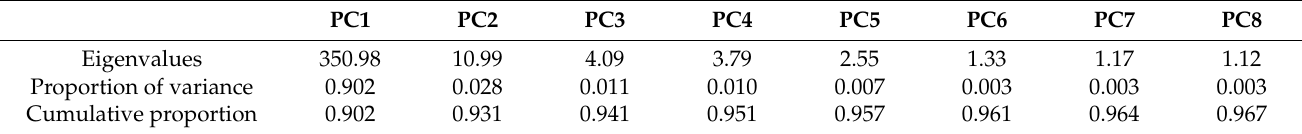
Table 1. Eigen-analysis of the correlation matrix of SITS.